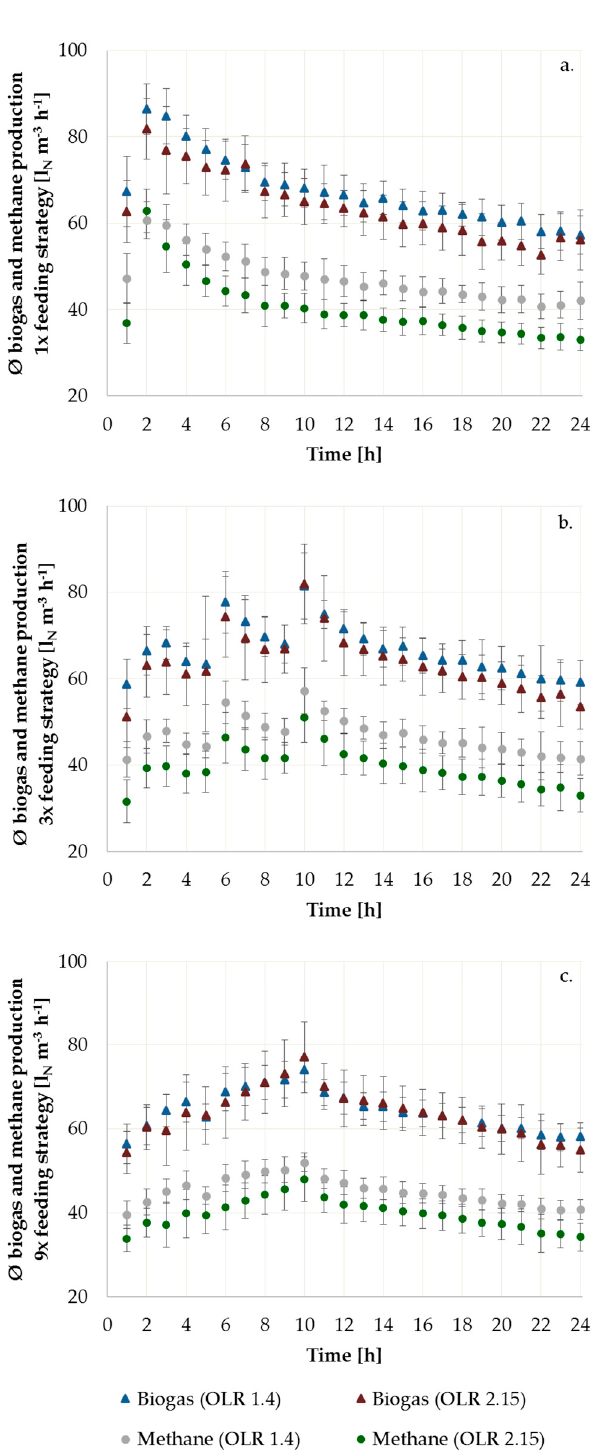
Figure 3. Average hourly biogas and methane production [l N m − 3 h − 1 ] of the semi-continuous experiment for the 1x ( a ), 3x ( b ) and 9x ( c ) feeding strategies. The data was collected over 16 working days for feedstock 1 (OLR 1.4 kg vs. m − 3 d − 1 ) and 34 working days for feedstock 2 (OLR 2.15 kg vs. m − 3 d − 1 ). Feedstock 1: 1x: n = 32; 3x, 9x: n = 48; Feedstock 2: 1x, 9x: n = 68, 3x: n = 102.